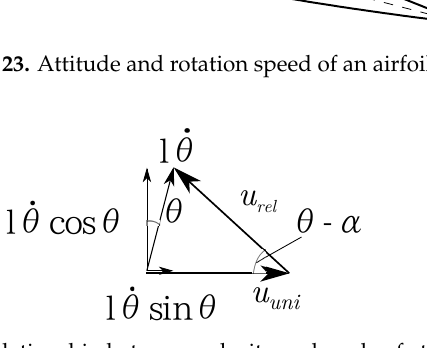
Figure 24. Geometric relationship between velocity and angle of attitude and